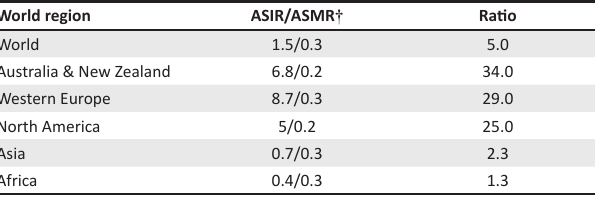
TABLE 1: Testicular cancer incidence versus mortality rates across regions. World region ASIR/ASMR † Ratio World